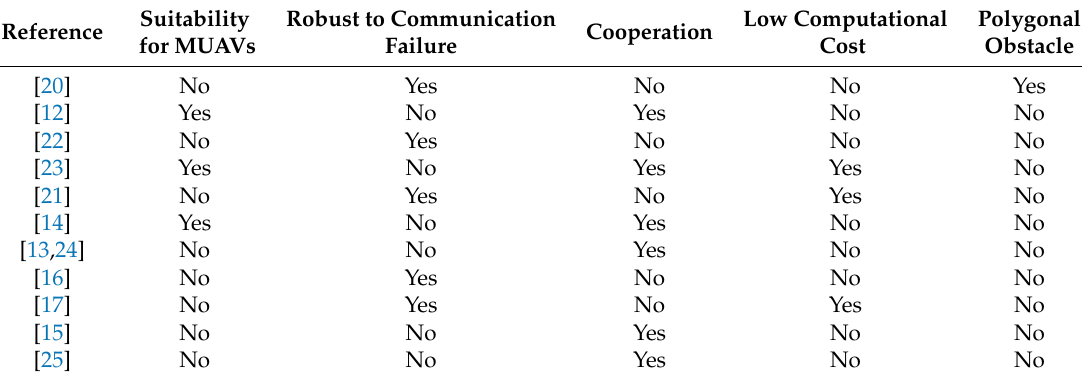
Table 1. Limitations of existing velocity obstacle